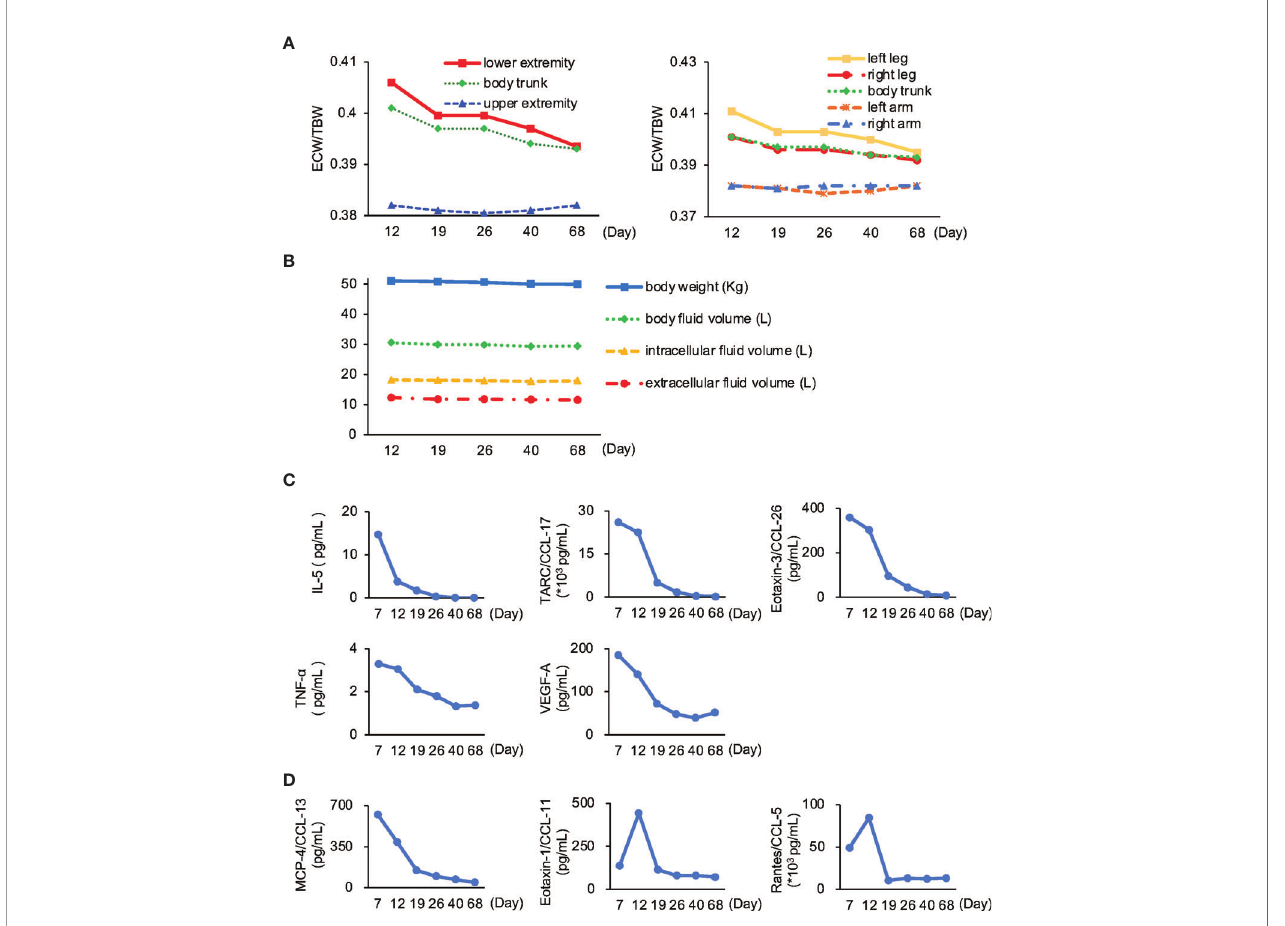
FIGURE 2 | Body impedance analysis and cytokines/chemokines (A) The ratio of extracellular water to total body water (ECW/TBW). Lower extremity, especially left leg showed the most severe edema. The normal range for ECW/TBW for edema is less than 0.39 (8 – 11). (B) Time series of body weight and fl uid volume in each part remained unchanged throughout the course of illness. (C) Cytokines and chemokines known to be involved in NEAE. IL-5, interleukin-5; TARC, thymus-and activation-regulated chemokine; CCL, C-C motif chemokine ligand; TNF- a , tumor necrosis factor- a ; VEGF-A, vascular endothelial growth factor-A. (D) Cytokines and chemokines newly reported to be involved in NEAE. MCP-4, monocyte chemoattractant